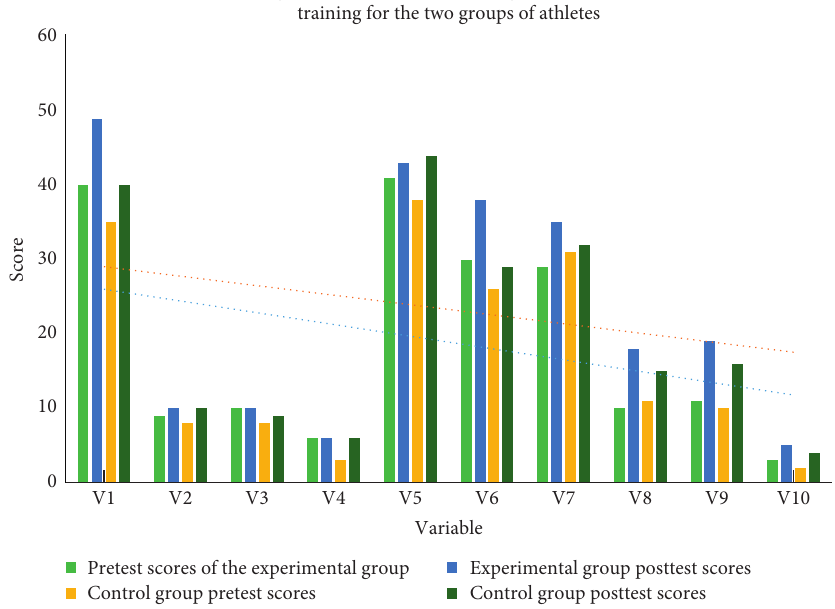
Figure 6: Changes in different forms of strength before and after training for the two groups of Table 3: General descriptive statistical results of shoulder joint horizontal flexion and extension before and after the experiment. Shoulder horizontal flexion and extension 60 degrees/sec